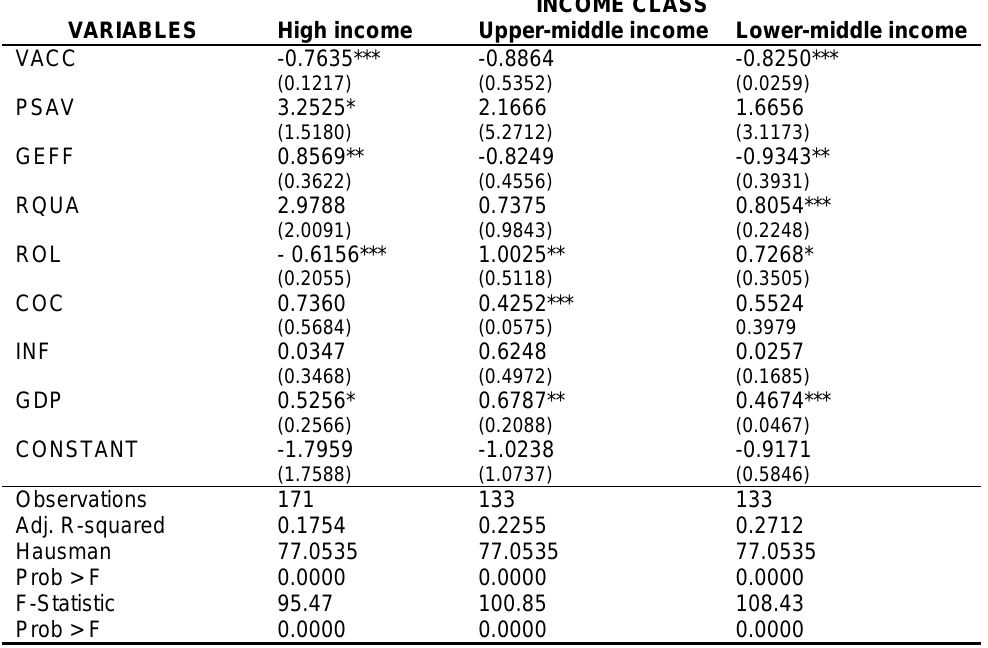
Table 8 . Regression results from fixed effects